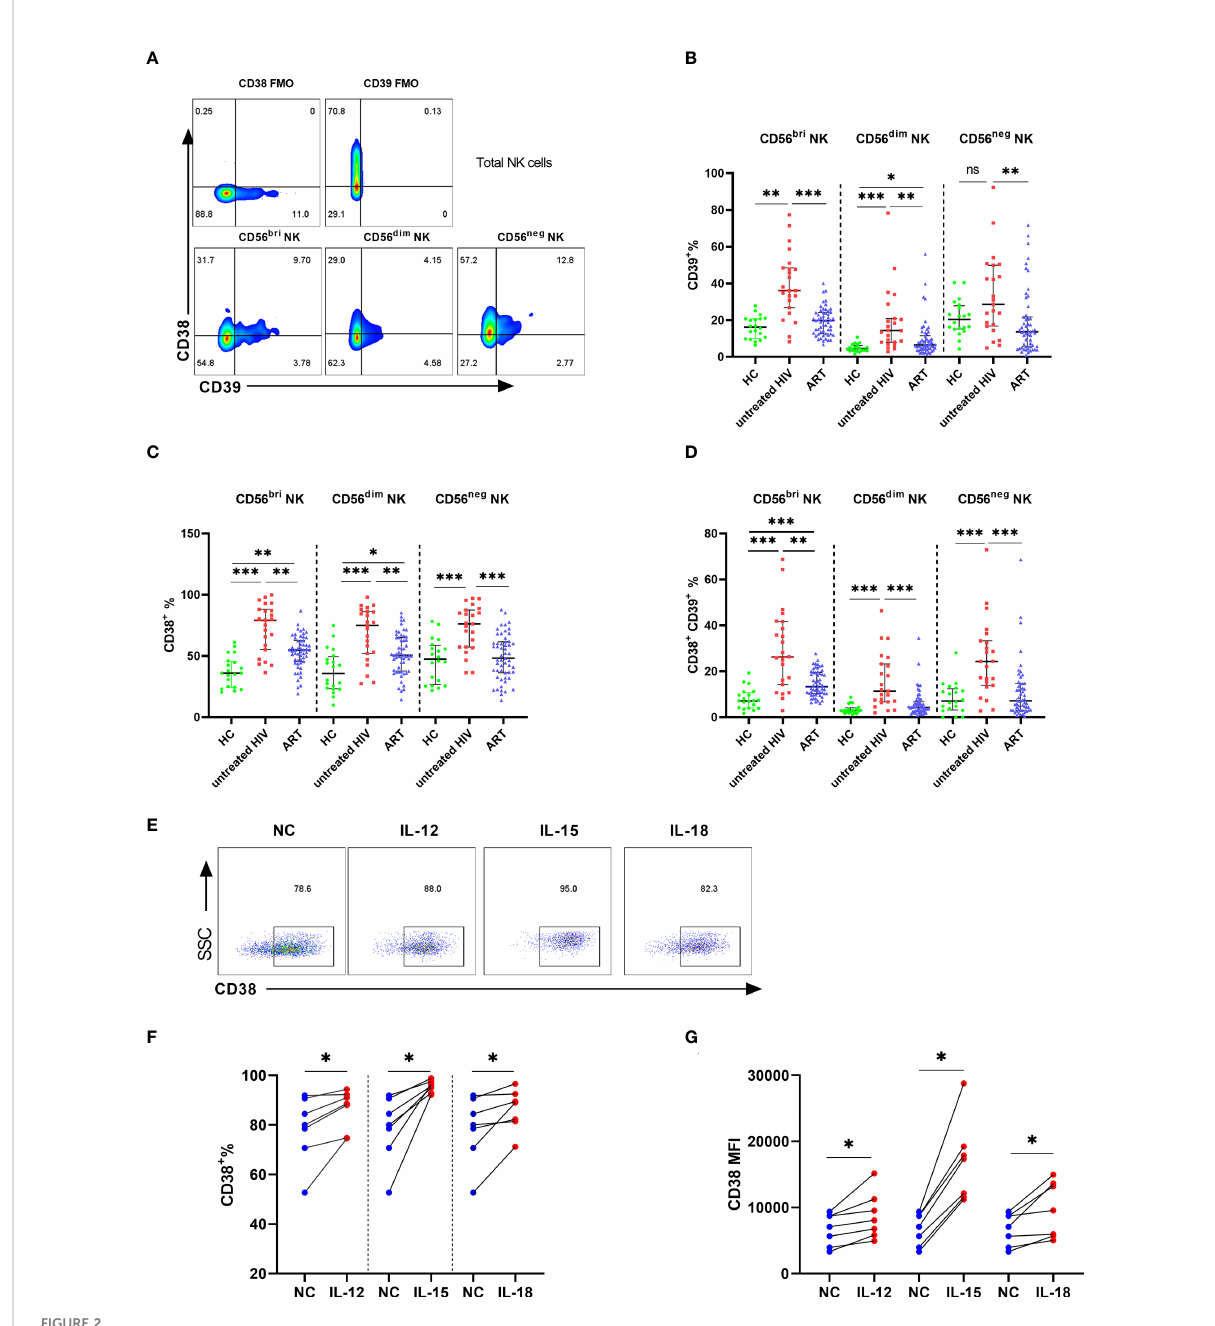
FIGURE 2 The expression of CD39 and CD38 on NK subsets. (A) The fl uorescence minus one (FMO) control of CD38/CD39 on total NK cells and representative fl ow cytometry plots showing three subsets of NK cells. (B) Comparison of the expression of CD39 on CD56 bri , CD56 dim , and CD56 neg NK cells in HC, untreated HIV, and ART groups. (C) Comparison of the expression of CD38 on CD56 bri , CD56 dim and CD56 neg NK cells in HC, untreated HIV and ART groups. (D) Comparison of the co-expression of CD38 and CD39 on CD56 bri , CD56 dim , and CD56 neg NK cells in HC, untreated HIV and ART groups. (E) The representative fl ow cytometry dot plots of CD38 expression on NK cells stimulated by IL-12/15/18. (F) Comparison of the percentage of CD38 + NK cells from HIV seropositive individuals in the negative control (NC) group and NK cells stimulated with IL-12, IL-15, and IL-18, respectively. (G) The MFI of CD38 on NK cells from HIV infected individuals between negative control (NC) group and the group stimulated with IL-12, IL-15, and IL-18, respectively. *p < 0.05, **p < 0.01, ***p < 0.001, ns: no signi fi